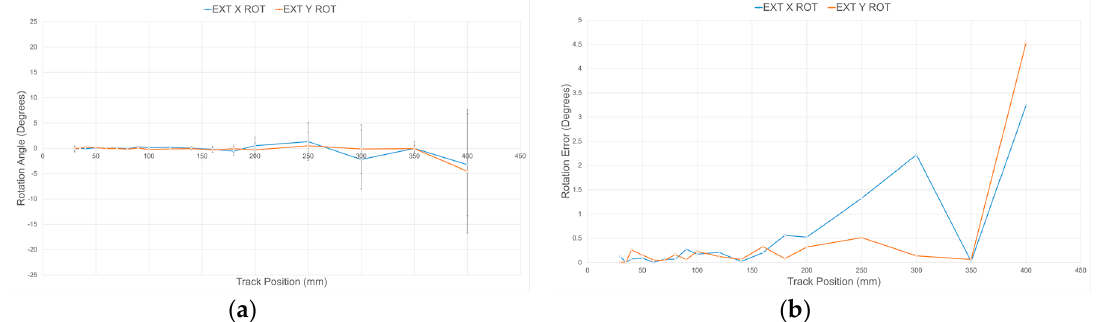
Figure 14. ( a ) Calibrated output of IR range sensors over range of operation and standard deviation on specific calibration points, and ( b ) distance error over range of operation.